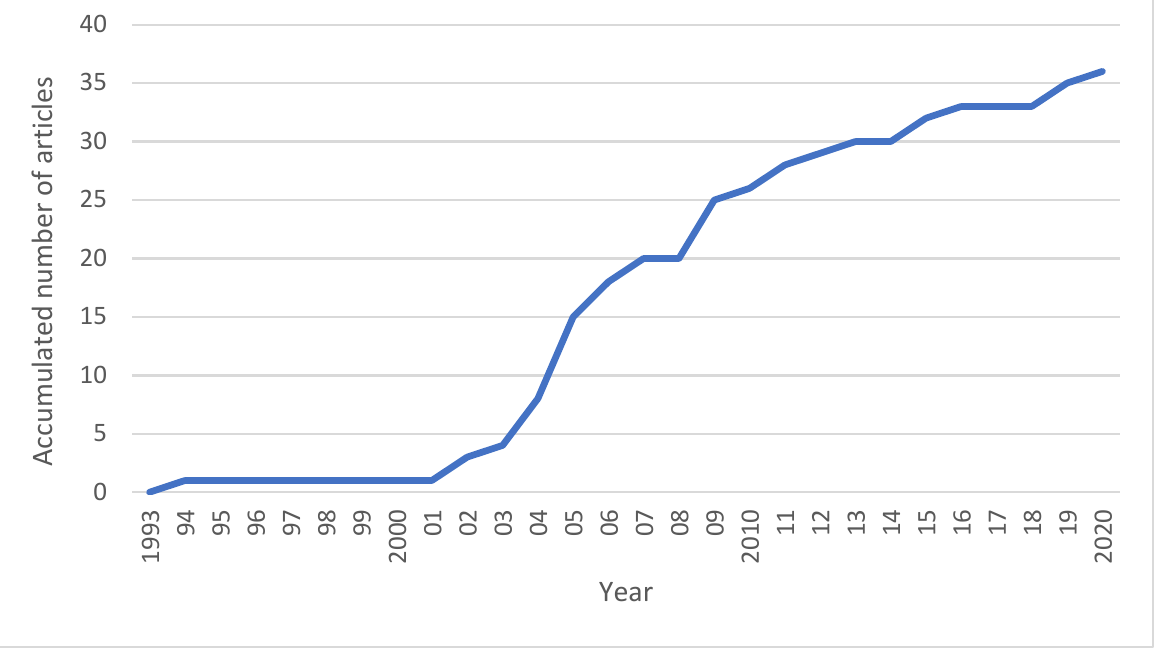
Figure 2. Accumulated number of articles fulfilling the inclusion criteria for systematic reviews of studies evaluating ECSWT in sport and companion animals published during 1993 – 2020.